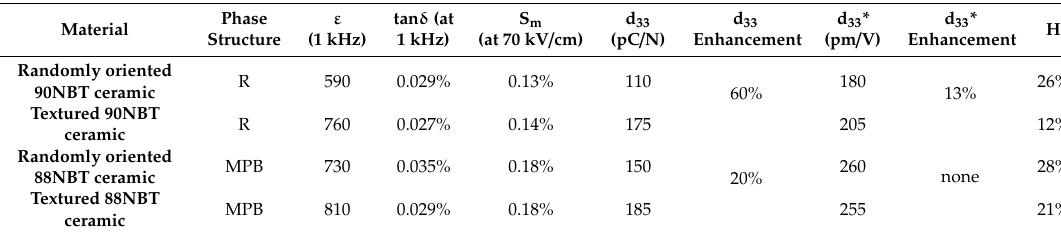
Table 1. The properties of 88NBT ceramics, and 90NBT